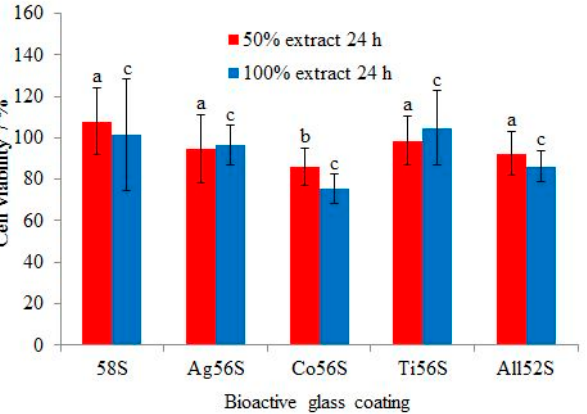
Figure 4. Cytotoxicity of bioactive glass coatings on MC3T3-E1 osteoblast-like mouse cells. Different letters mean a significant difference between groups ( p < 0.05).